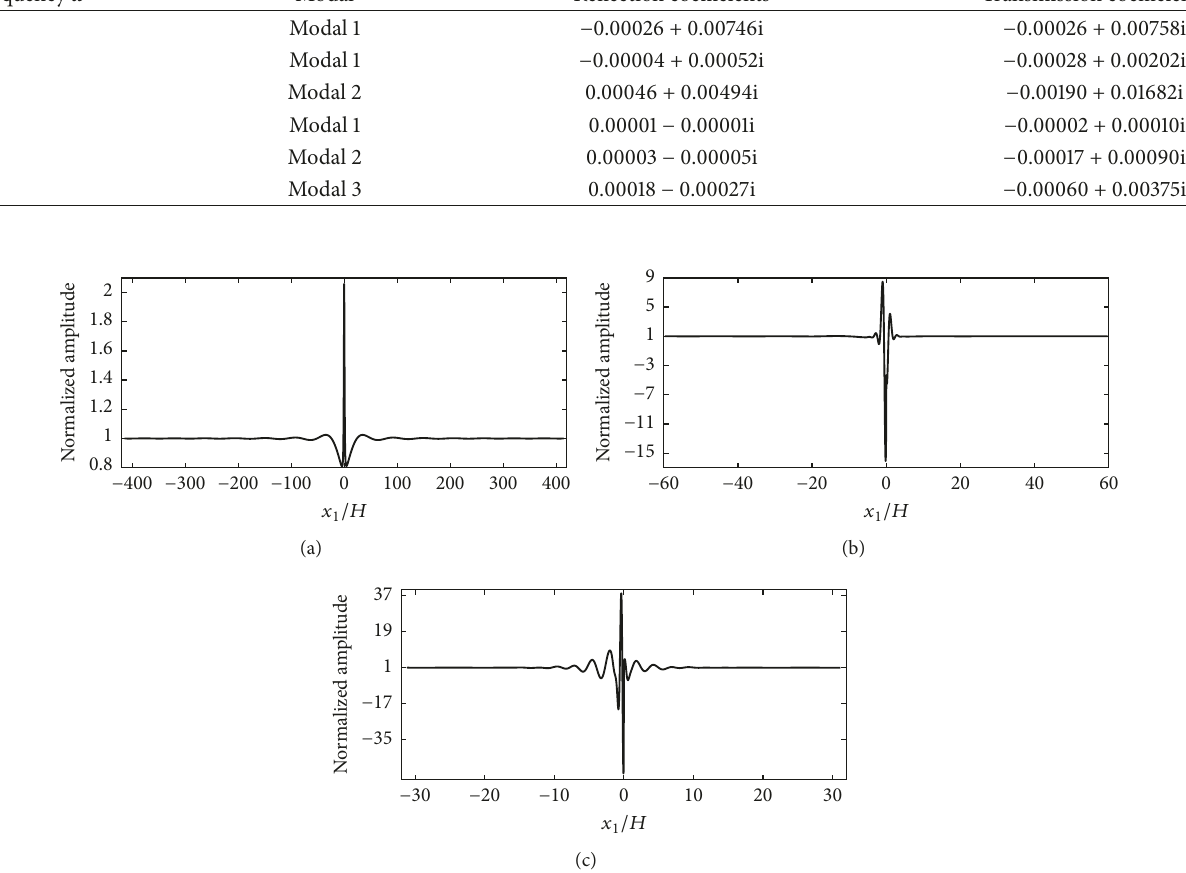
Figure 9: Normalized amplitudes of upper boundary due to a circle defect in half-plane: (a) 𝜔 = 0.8 ; (b) 𝜔 = 5 ; (c) 𝜔 = 9.5 .